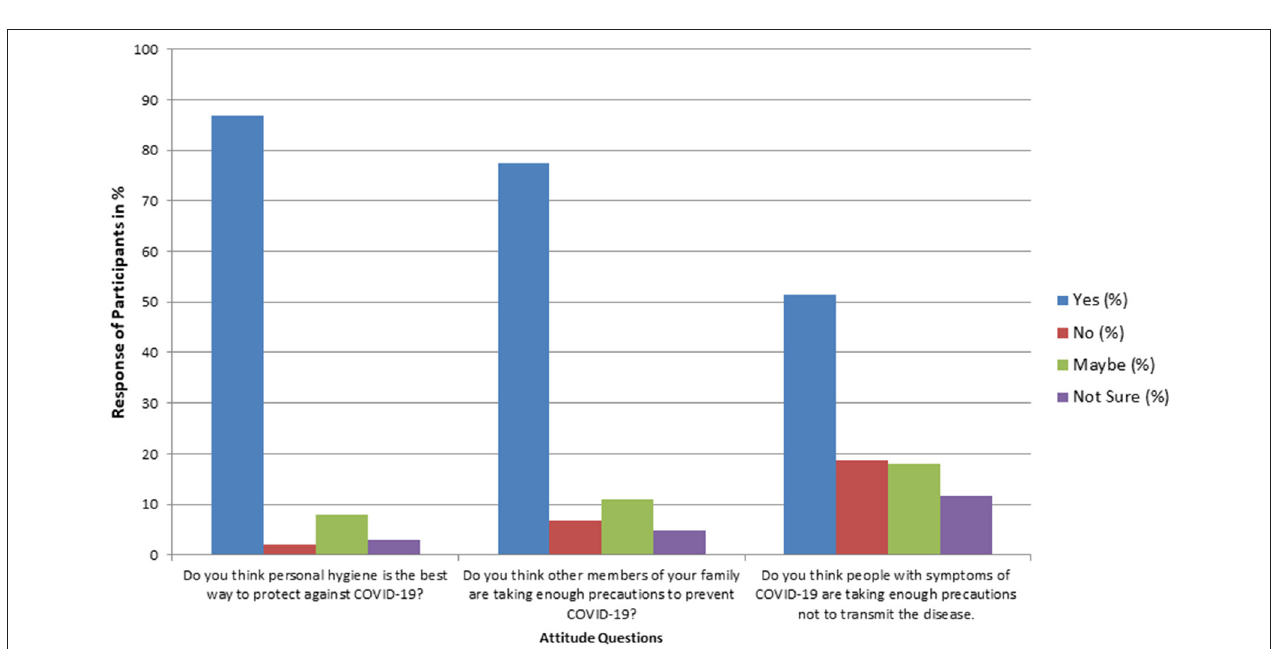
FIGURE 2 | Percentage response of participants on important questions regarding the attitude for COVID-19 ( N = 3,854). out totaled 90%. In all 55% were likely to visit relatives during the lockdown. Almost half of the community were not following the guidelines to prevent COVID-19 ( Supplementary Table 1 ). The practices for participants